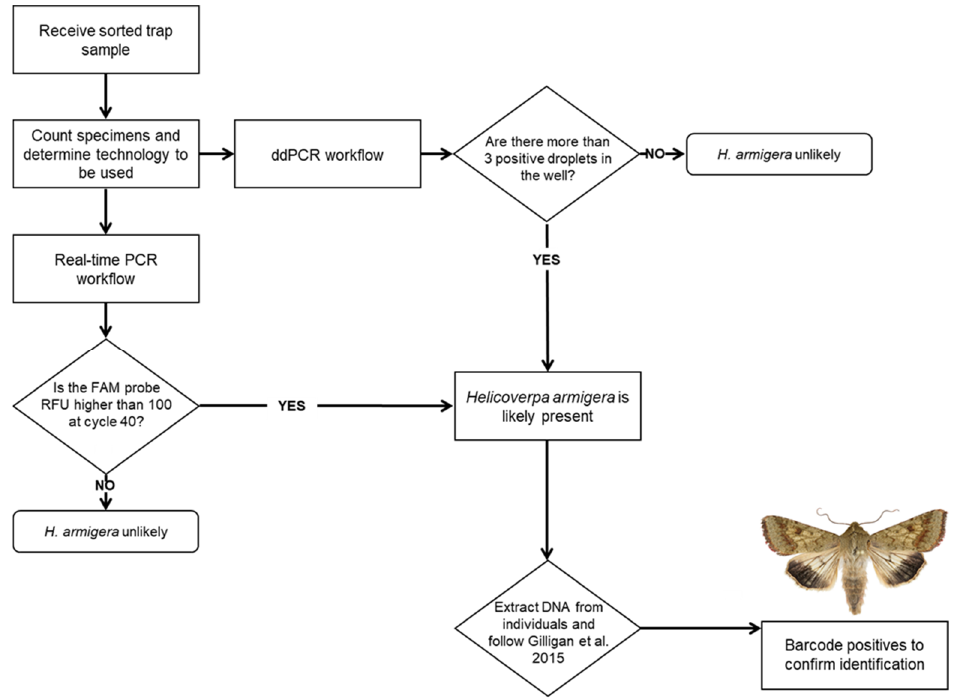
Figure 7. Flowchart describing assay choice and identification workflow.